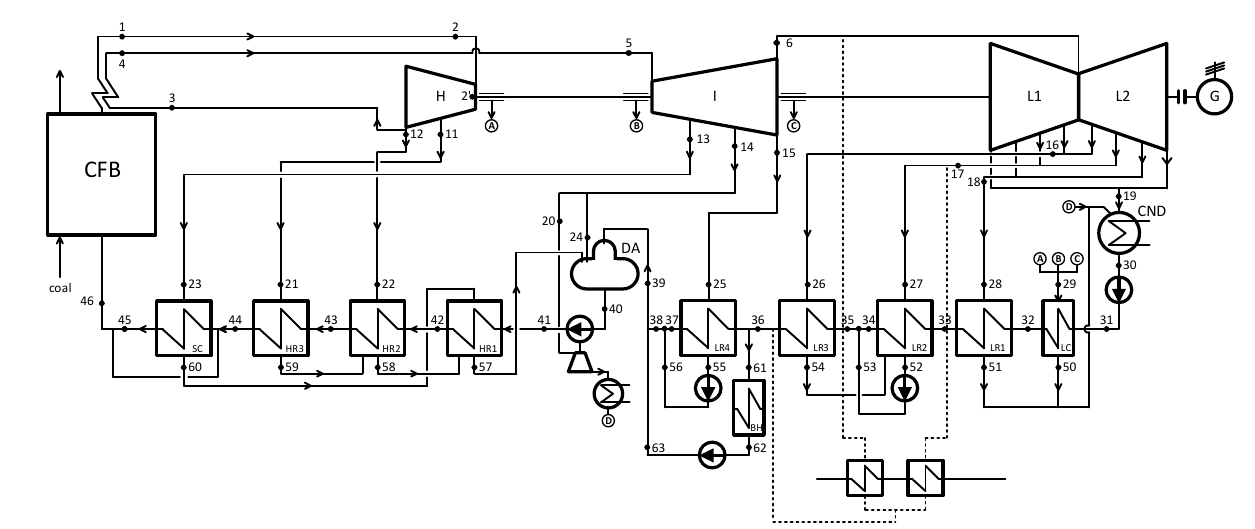
Figure 2. Simplified diagram of the Łagisza 460 MW unit.